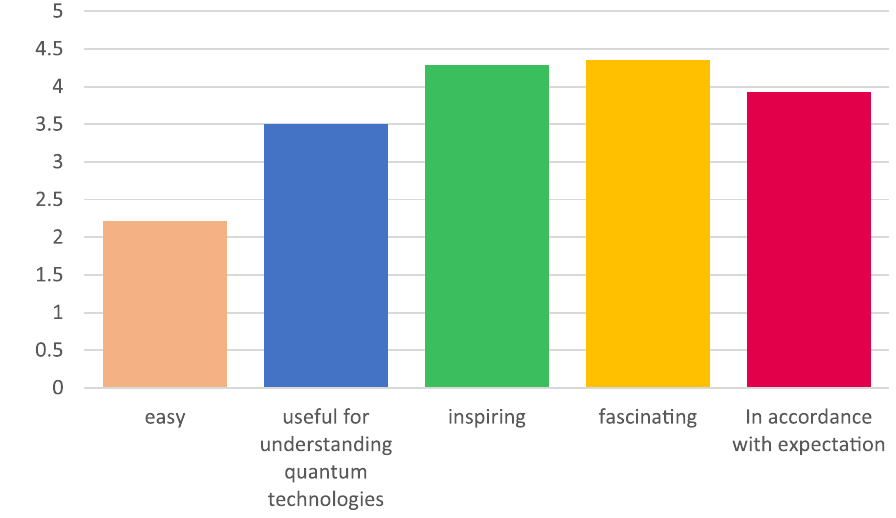
FIG. 18. General evaluation of the activity on teleportation: Average score awarded by students for each aspect.